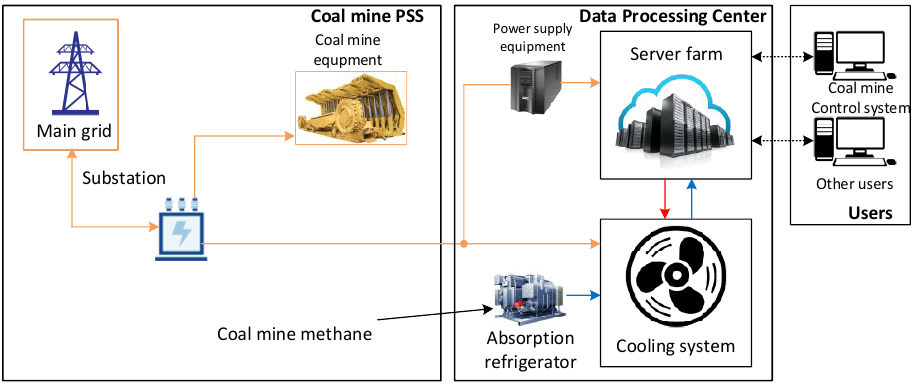
Figure 7. Power supply structure of coal mine and DPC when using